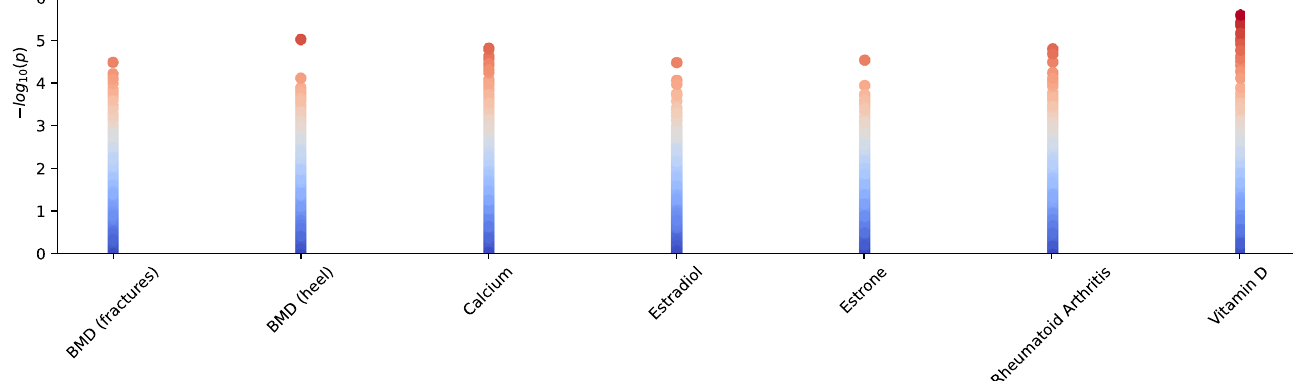
Fig 7. Resulting p -values for cross-scoring several GWAS related to osteoporosis against the severe COVID-19 GWAS. The top figure (A) shows the anti-coherent case and the bottom figure (B) the coherent case. The red dotted line marks the Bonferroni significance threshold of 3.9 × 10 − 7 (0.05 divided by the 18453 genes tested and 7 traits). We observe Bonferroni significant enrichment for RA plus enrichments in vitamin D and calcium with p -values < 10 − 5